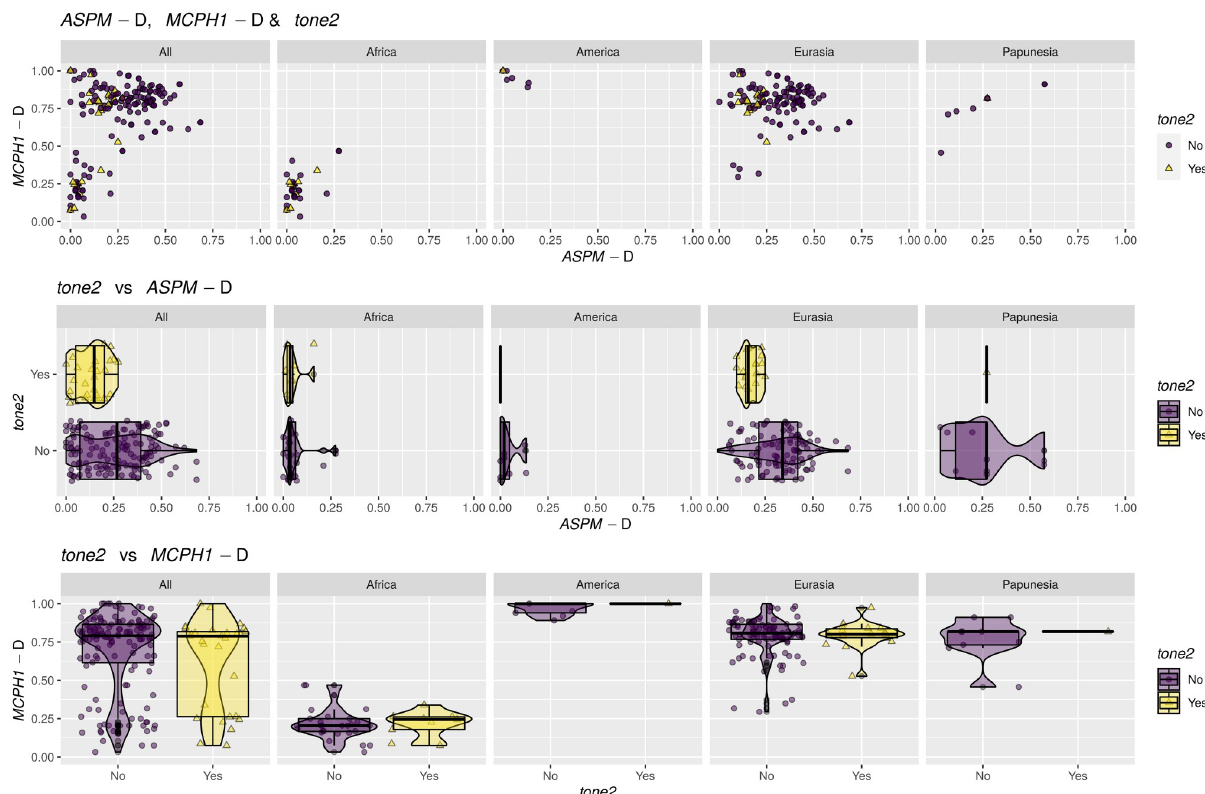
Fig 17. Relationship between tone2 and the population frequency of ASPM -D and MCPH1 -D in the whole database and separately by macroarea. Same conventions as in Fig 8.